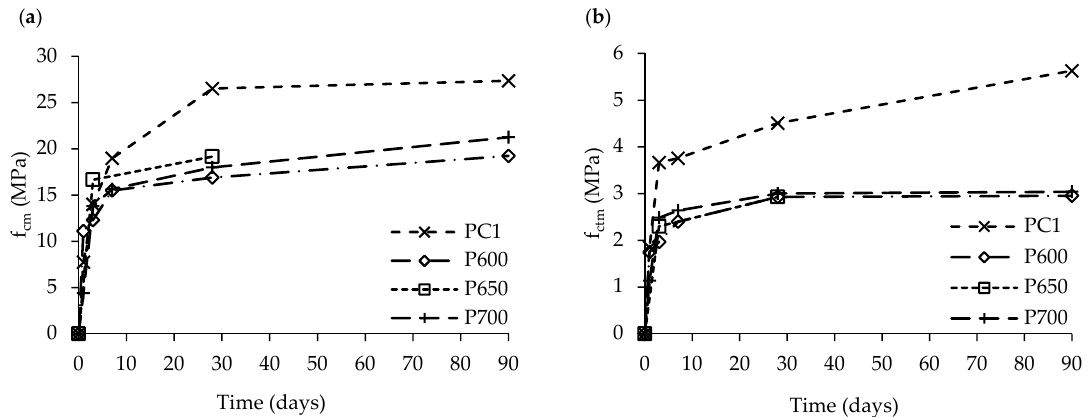
Figure 14. Mechanical properties of PC1, P600, P650 and P700 over time: ( a ) compressive strength, f cm ; and ( b ) flexural strength, f ctm .